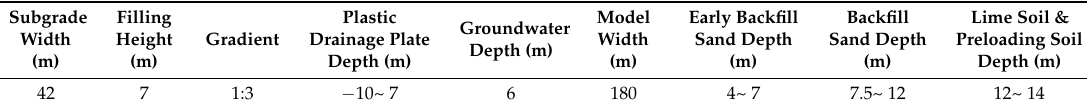
Table 3. The model size parameters.